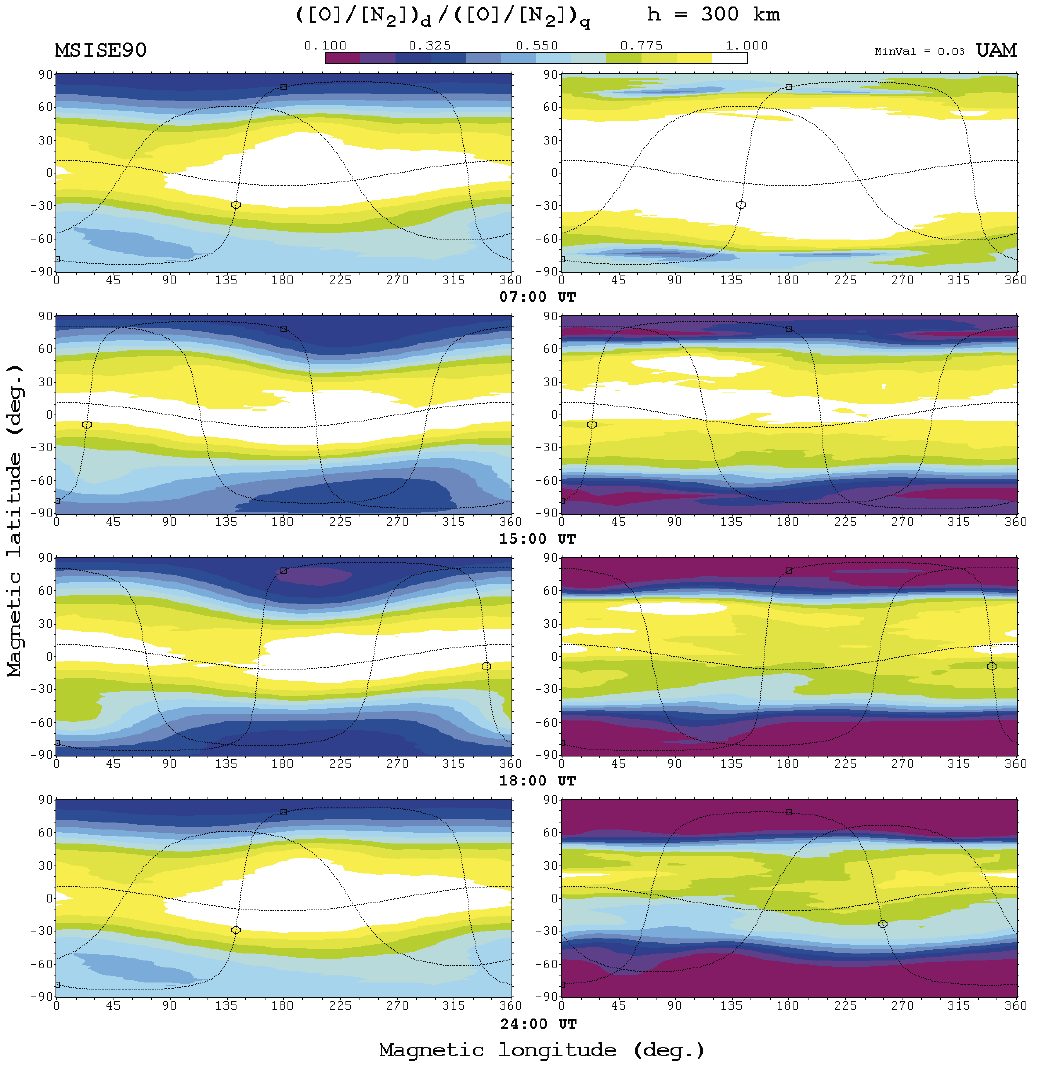
Fig. 4. The same as in Fig. 2 but for the neutral composition disturbance R (O/N